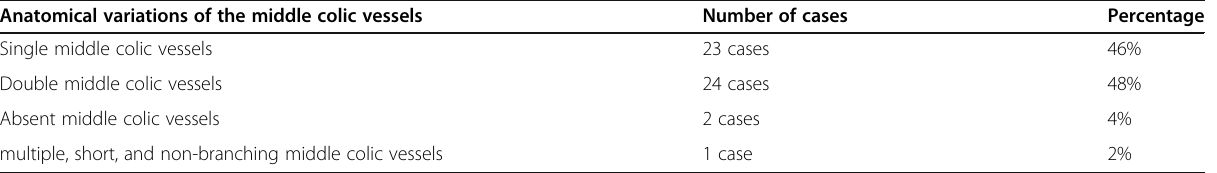
Table 1 The incidence of the anatomical variations of the middle colic vessels in this case series (50 cases) Anatomical variations of the middle colic vessels